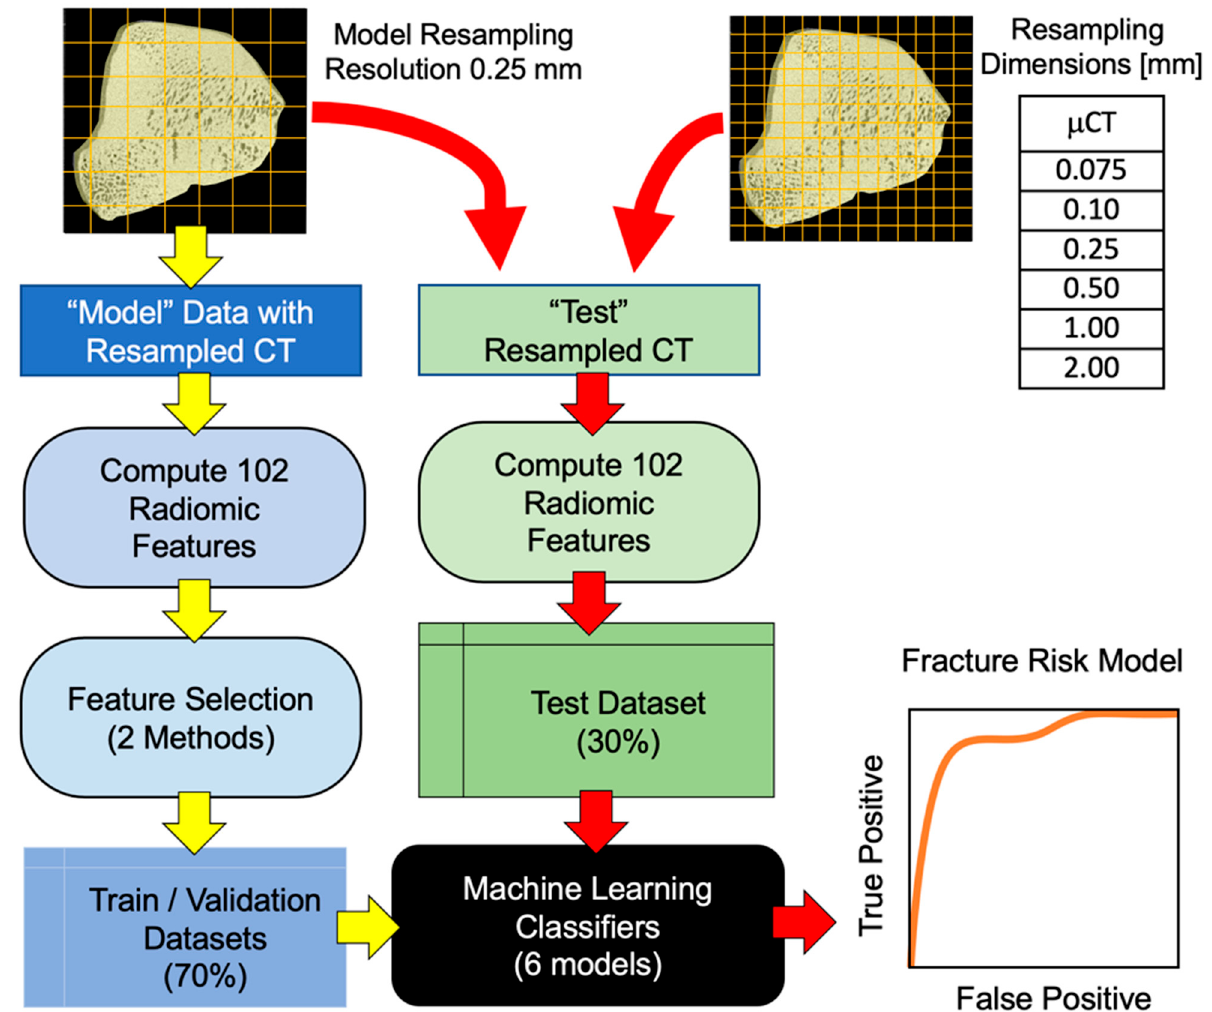
Figure 2. Experimental design of the µ CT radiomics-based fracture risk modeling study. After segmenting the PSBs in the µ CT, 102 radiomic features were computed using 6 different resampling dimensions. A resampling resolution of 0.25 mm was used as baseline data from which the top 3, 5, 10 and 20 expressed features were selected (using 2 different feature selection methods). Then, 6 classification models were trained and validated using these features, and the performance of these models were tested and ranked based on their accuracy. Finally, the top performing models, which were developed using 0.25 mm resolution radiomics data, were tested with the same PSB radiomics data using different resampling dimensions.